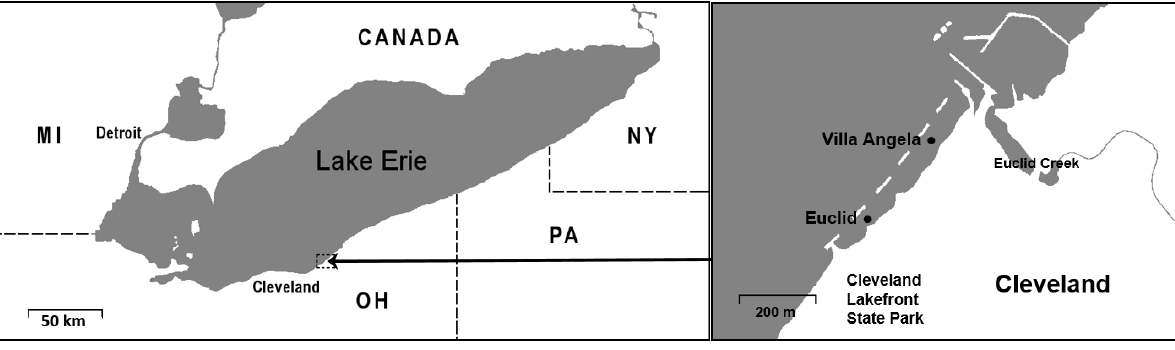
Figure 1. Two beach sites (sampling sites) in Lake Erie. Euclid (41°35′9″N; 81°34′1″W); Villa Angela (41°35′2″N;